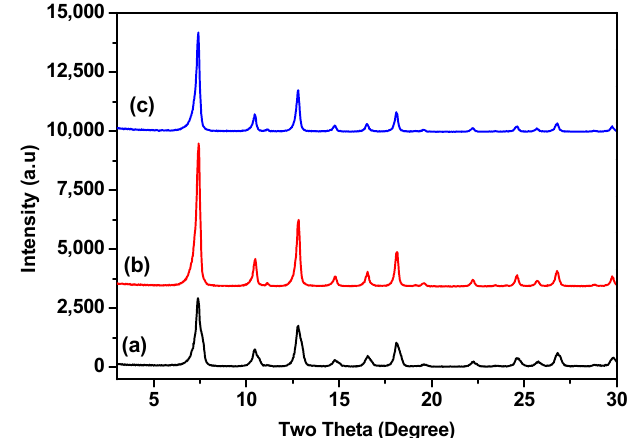
Figure 8. XRD patterns of fresh ZIF-8 (a), recovered ZIF-8 after three cycles (b) and after six cycles (c) from the reaction between 2-nitrobenzladehyde and malononitrile in water at 40 °C.